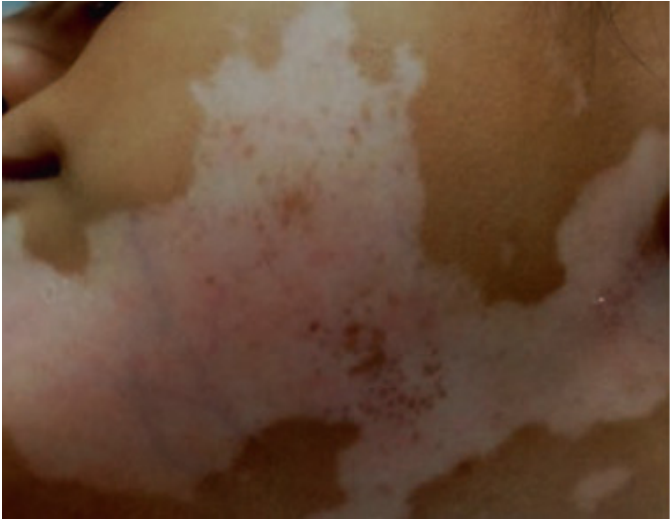
Figure 24. A clinical picture of vitiligo in a filipino individual [255]. ©2017 Springer. One of the most likely causes of vitiligo is a disorder of tyrosine (Tyr) metabolism (Tyr is a precursor of melanin). During the catalytic oxidation of Phe to Tyr, H 4 Bip is oxi- dized to 4a-OH-tetrahydrobiopterin (carbinolamine) (Figure 25). Dehydration of carbino- lamine to quinoid dihydrobiopterin (qH 2 Bip) is catalyzed by pterin-4a-carbinolamine dehydratase (PCD) (EC 4.2.1.96). qH 2 Bip has a strong inhibitory effect on PCD, while 7,8- dihydrobiopterin (H 2 Bip) does not. In the absence of PCD, dehydration of carbinolamine proceeds non-enzymatically and leads to the formation of both H 2 Bip and 7-H 2 biopterin, or dihydroprimapterin [256]. 7-H 2 Bip, in contrast to 4a-OH-tetrahydrobiopterin, has an inhibitory effect on PAH [28]. Finally, the conversion of qH 2 Bip to H 4 Bip occurs with the participation of dihydropteridine reductase in a NADH-dependent reaction. Thus, the regeneration of H 4 Bip is necessary for the metabolism of phenylalanine, since: (1) a con- stant supply of H 4 Bip is required for the functioning of PAH; and (2) the accumulation of metabolites resulting from the non-ezymatic rearrangement of 4a-OH-tetrahydrobiopterin is unfavorable. H 4 Bip directly regulates tyrosinase activity. The H 4 Bip binding site in tyrosinase